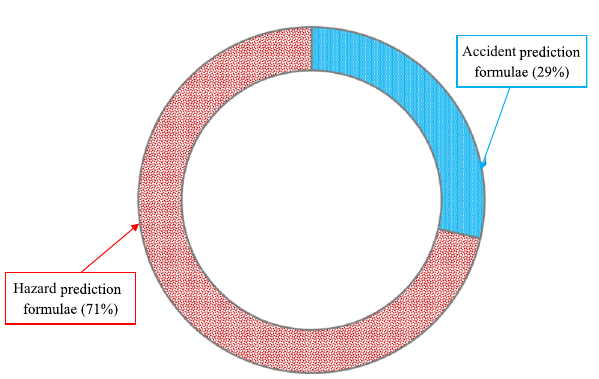
Fig. 2 A distribution of the identified accident and hazard prediction